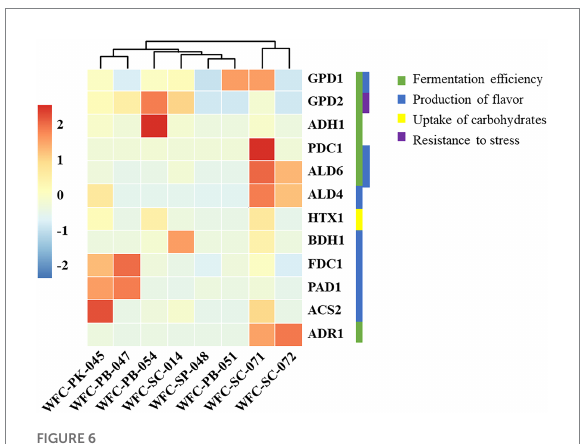
FIGURE 6 Changes in gene expression. The results are expressed as the median of the difference in gene expression level before and after the fermentation of triplicate samples. Genes in green, blue, yellow, and purple are related to fermentation capacity, flavor production, carbohydrate uptake, and stress resistance, respectively. Strains WFC-SC-071 and WFC-SC-072 demonstrated ideal expression levels of most genes associated with aroma production, carbohydrate uptake, and yeast fermentation